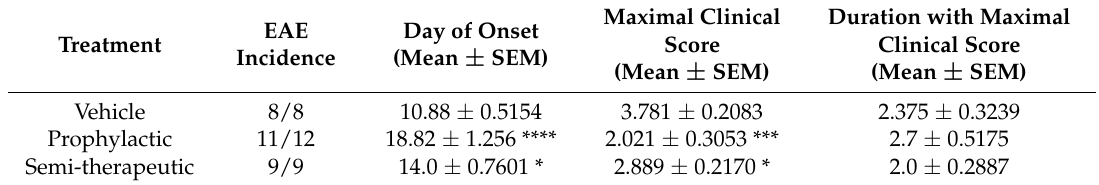
Table 1. GLP-1 RA dulaglutide administration extremely influences the disease progression of EAE.